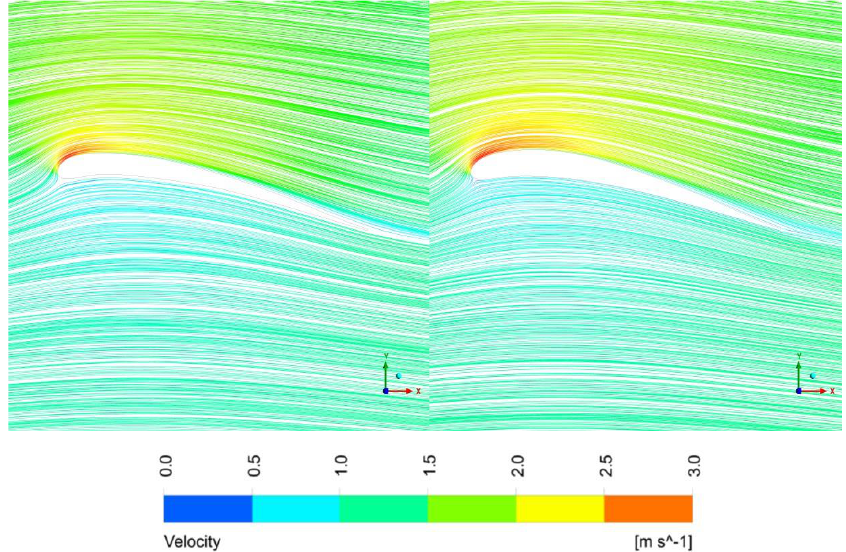
Figure 14. Streamline diagram of the optimized airfoil velocity of the sparrowhawk at an angle of attack of 10°. (Initial airfoil on the left, optimised airfoil on the right).